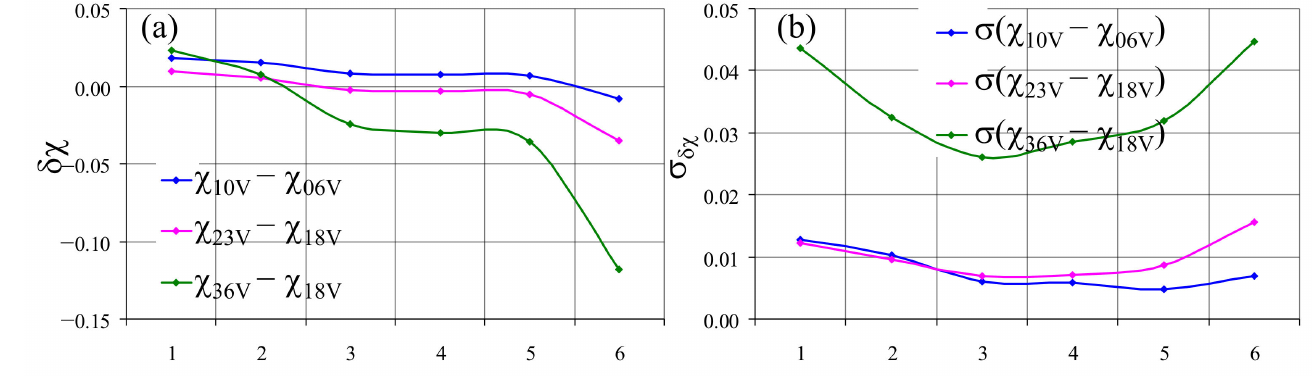
Figure 7. Dependence of the winter averaged (calculated on the basis of data for January–May and for November and December 2020) values of gradients of the sea ice emissivity δχ ( a ) and their standard deviations σ δχ ( b ) on the sea ice type: 1—nilas, 2—young ice, 3—thin FY ice, 4—medium FY ice, 5—thick FY ice, 6—MY